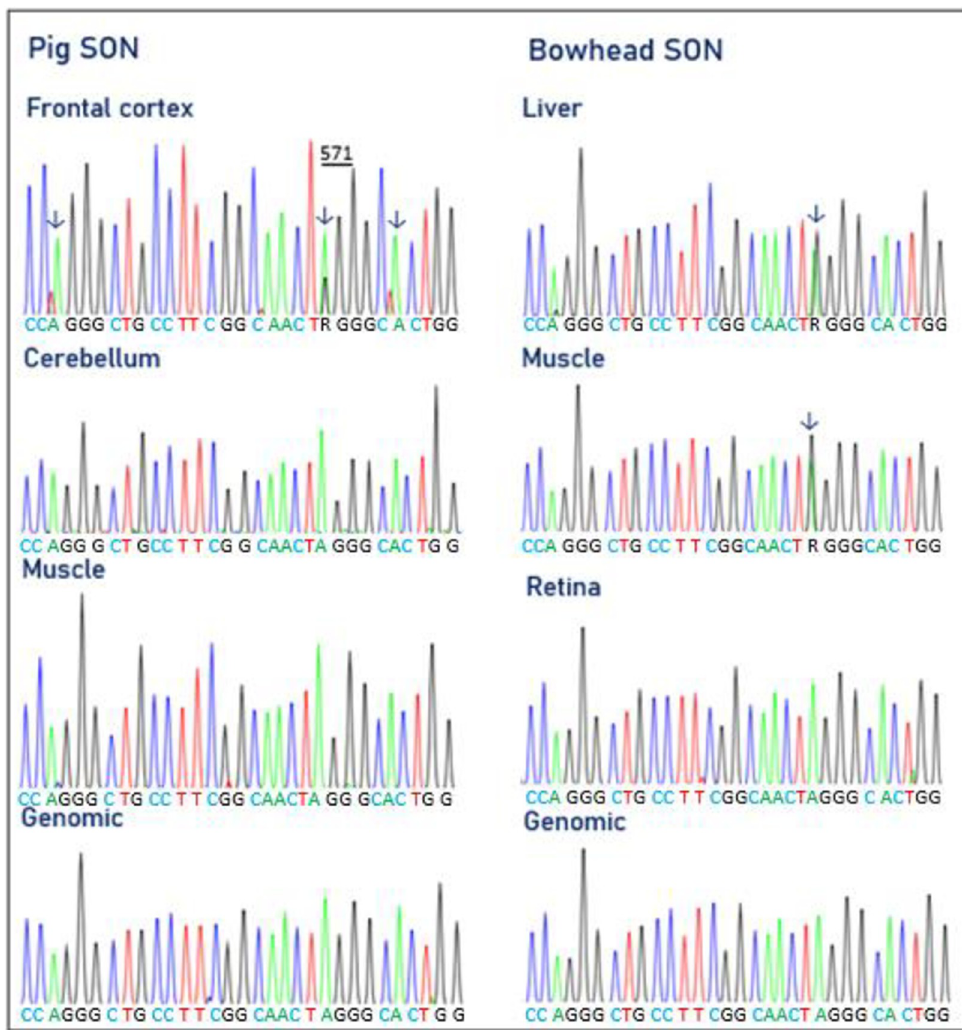
Fig 6. Electropherograms showing SON pre-mRNA editing in pig (left panel) and bowhead (right panel). In pig, SON editing is seen only in frontal cortex at position 571. In bowhead, SON editing is detected in liver and muscle. The adenosines subject to editing are indicated by